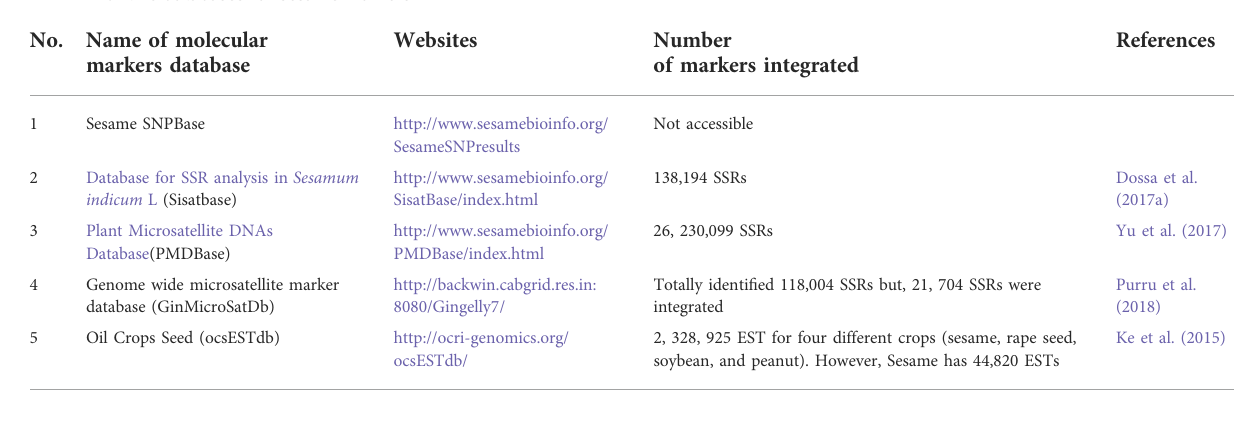
TABLE 2 Online databases for sesame markers.